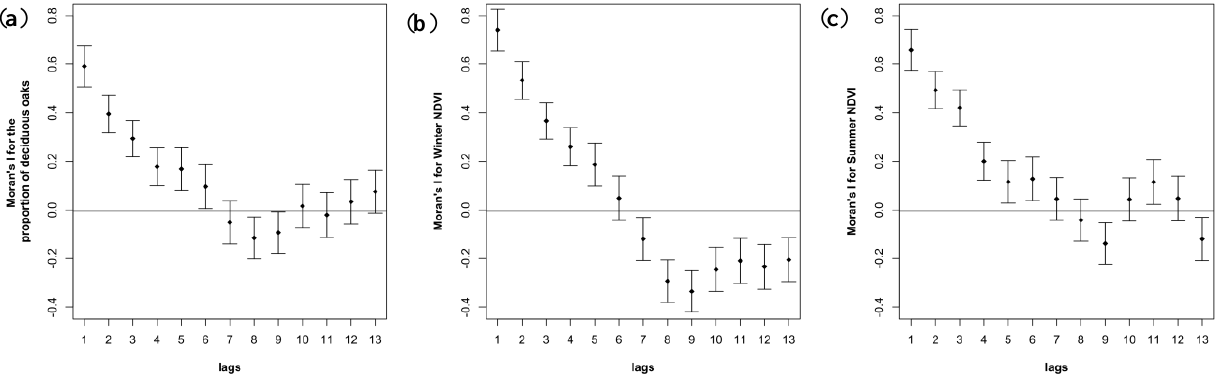
Figure 4. Spatial autocorrelation (Moran’s I estimate and its 95% confidence interval) measured in a 50 m radius to the nestbox across 13 distance classes (lags) of 158 m, in terms of ( a ) the proportion of deciduous vs. evergreen oaks; ( b ) winter NDVI;